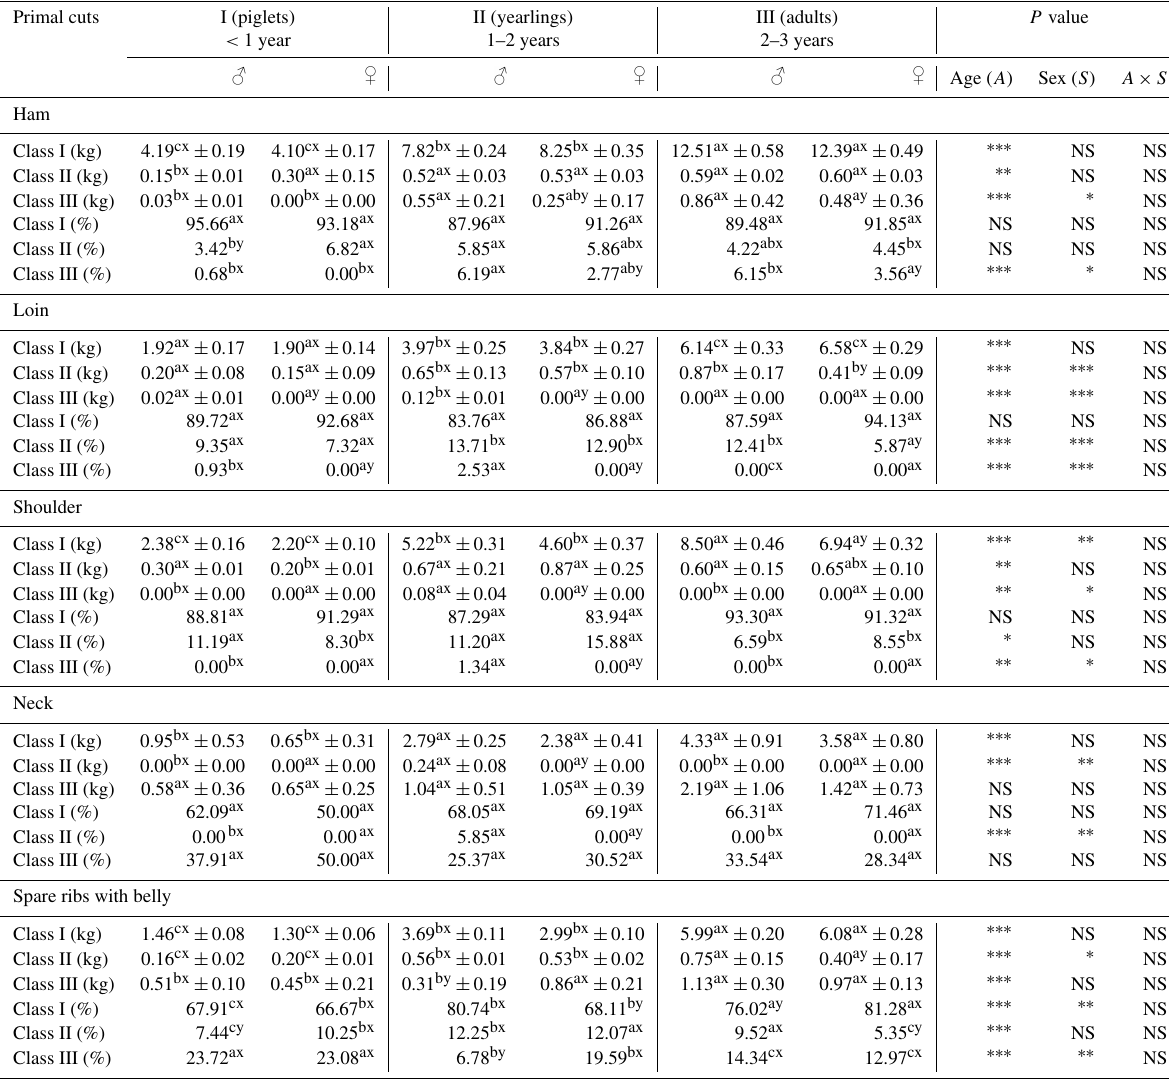
Table 5. Characteristics of wild boar meat from different primal cuts in weight and percentage of lean meat (mean ± SE). Primal cuts